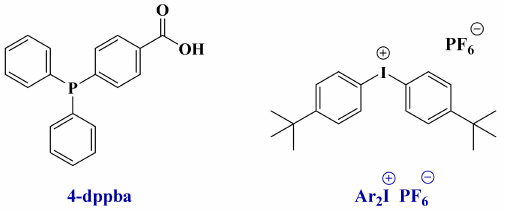
Figure 4. Chemical structures of the additives.